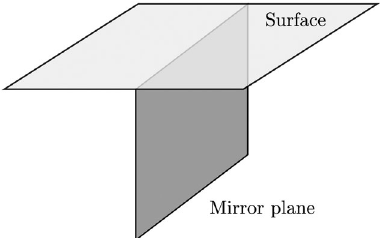
FIG. 4. Geometry of a symmetry-preserving surface of a 3D pgSPT phase protected by Z P 2 reflection symmetry, ignoring any translation symmetry. In the bulk, the system has been reduced to a 2D state lying on the mirror plane. The edge of the mirror plane coincides with the reflection axis of the